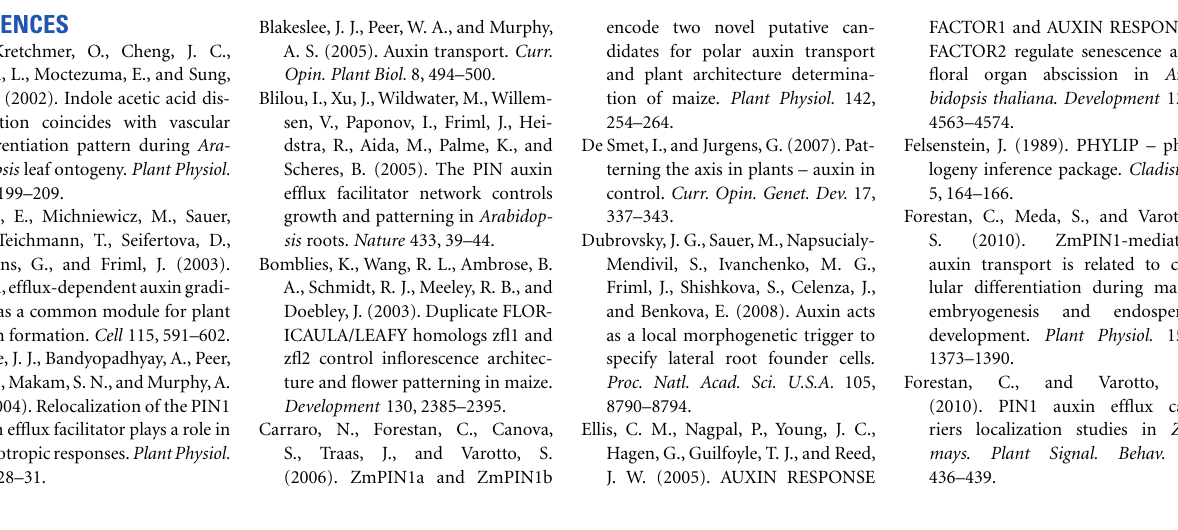
Table S1 | PIN sequences accession numbers. Accession numbers list, common name (where available) and respectively protein sequences of auxin efflux carriers considered in this work for phylogenetic analysis are reported for each species.While Arabidopsis thaliana and Zea mays PIN and PIN-like sequences were retrieved fromTAIR (www.arabidopsis.org) and MaizeGDB (www.maizegdb.org) databases, respectively, PIN protein sequences of the other species were identified by a family blast search in the Phytozome v7.0 database (www.phytozome.net/). Table S2 | Primer list. Primers used for cDNA and genomic full-length amplification, amplification of probes for in situ hybridization and expression analysis in vegetative and reproductive tissues (with relative number of circles considered in each PCR) are listed for each maize PIN and PIN-like gene. Table S3 | Maize PIN and PIN-like map position. Chromosomal position (obtained from www.maize.sequence.org database) of the newly identified maize PIN and PIN-like